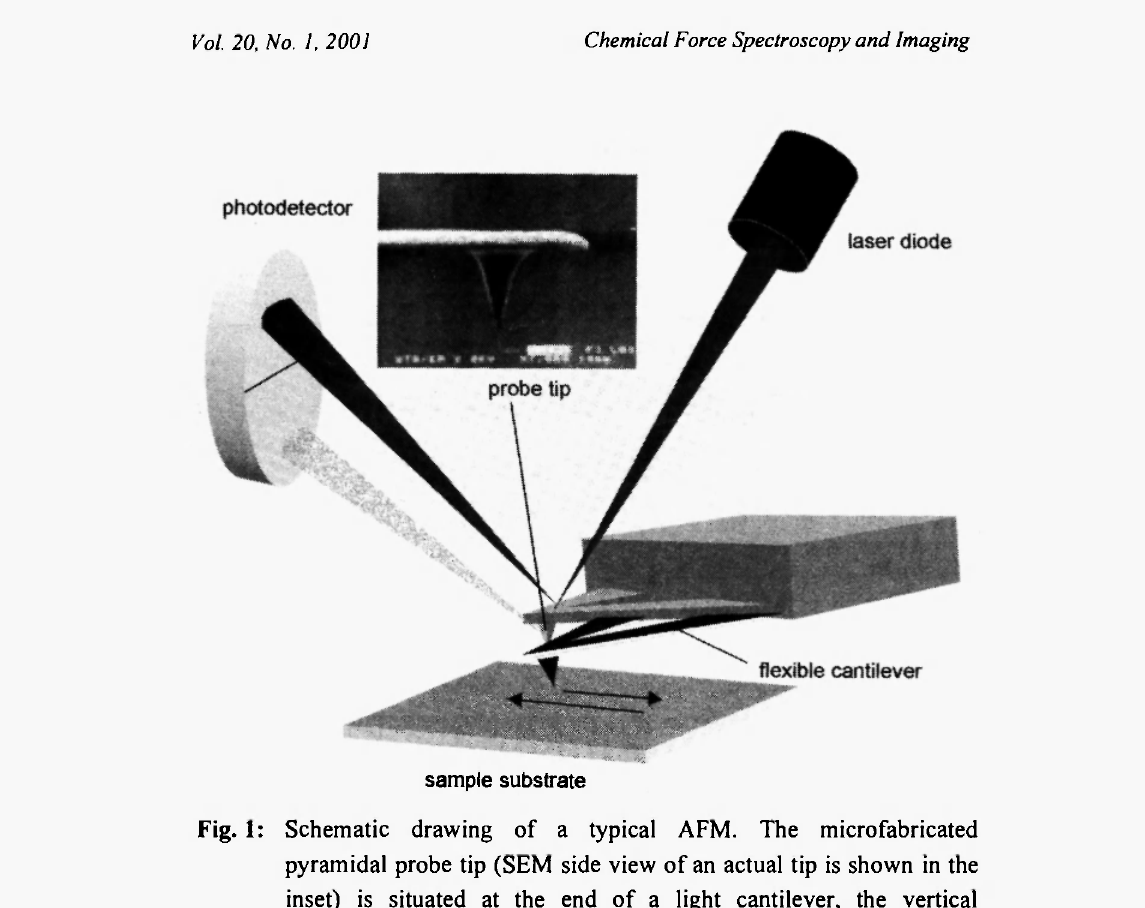
Fig. 1: Schematic drawing of a typical AFM. The microfabricated pyramidal probe tip (SEM side view of an actual tip is shown in the inset) is situated at the end of a light cantilever, the vertical displacement of which is sensed optically by the deflection of a laser beam. The tip is scanned over the sample in a raster fashion (or the sample is scanned under the tip) by piezo-electric ceramics and an image is formed by plotting the cantilever deflection as a function of position over the sample